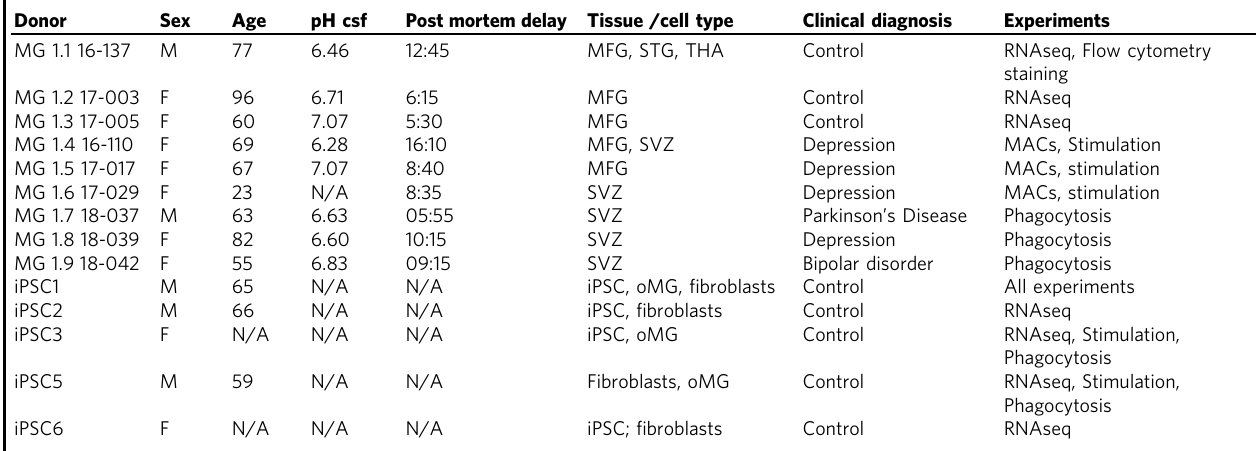
Table 1 Clinicopathological data of the fresh human brain tissue and iPSC donors including: donor number, sex, age, pH CSF, post mortem delay, tissue or cell type, clinical diagnosis, and for which experiments the tissue was used